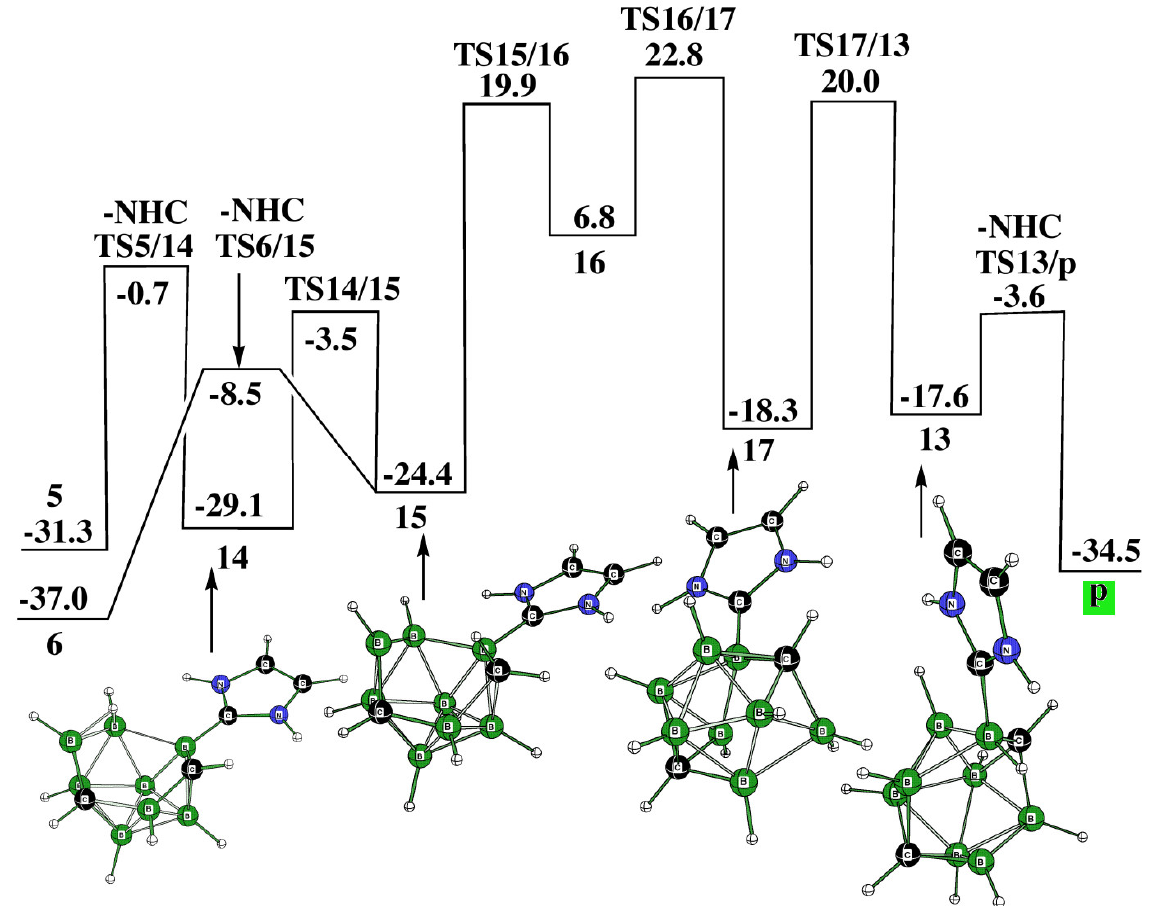
Figure 6. Relative free energies (kcal.mol − 1 ) of the individual stationary points on the potential energy surface (PES) of the reformation of p from both o-2 and m-2 (see Tables 1 and S1 and Section 3 for details).